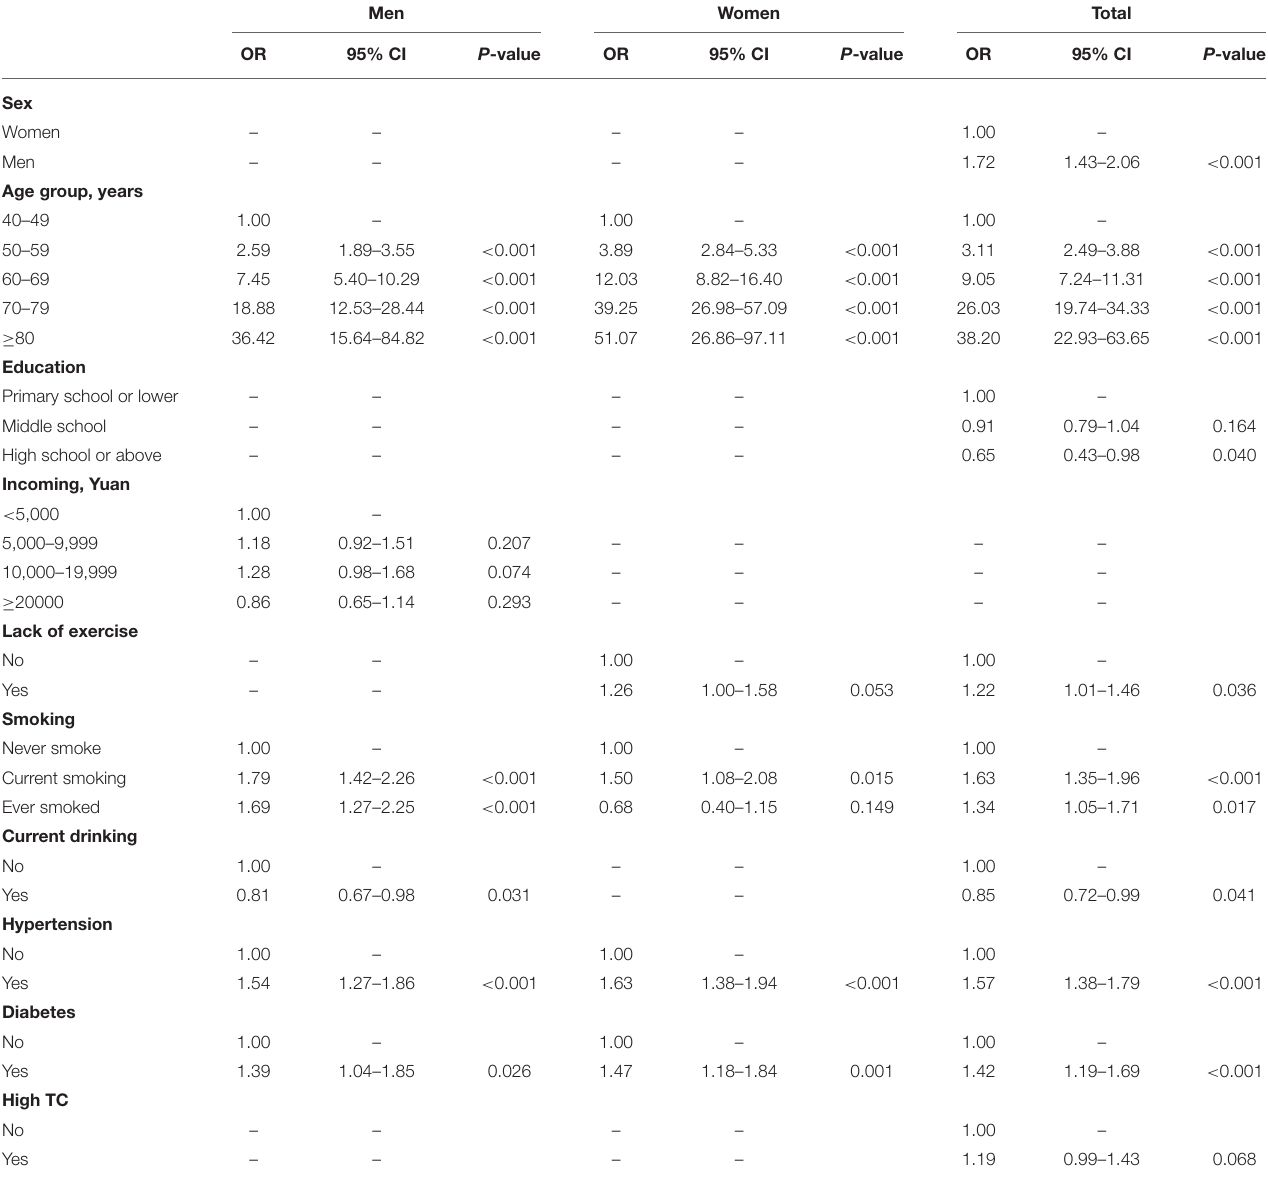
TABLE 3 | Multivariable-adjusted odds ratio for prevalence of carotid atherosclerosis in rural Northeast